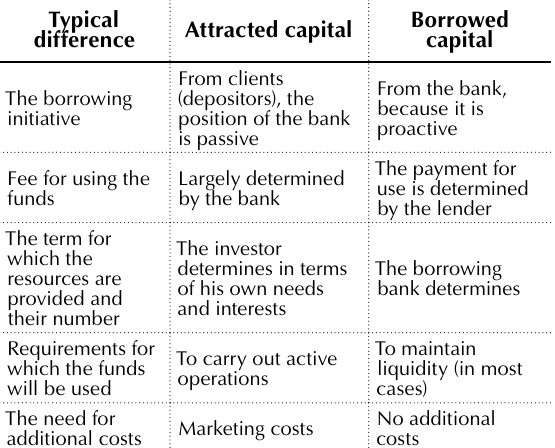
Table 1. The main differences between the a ttracted capital and the borrowed bank